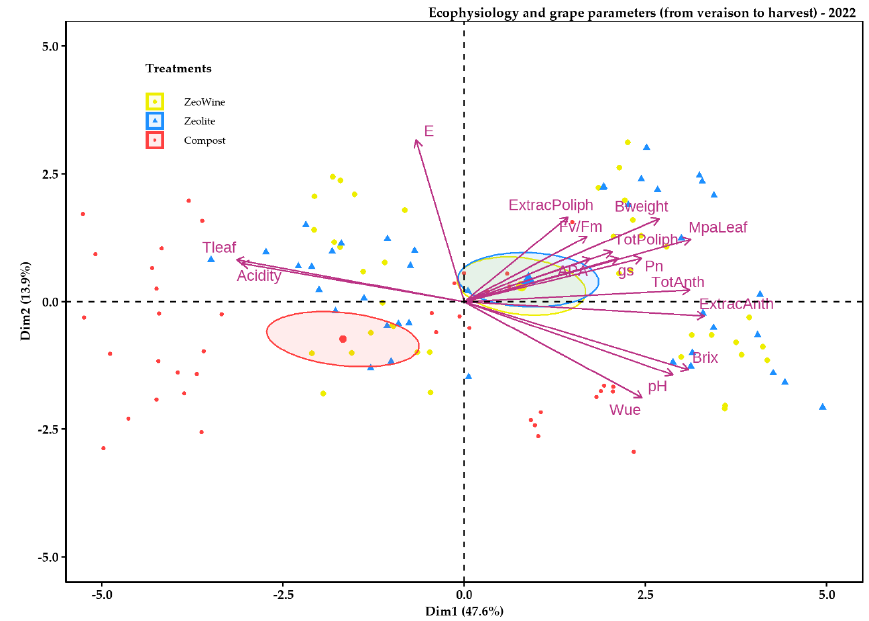
Figure 12. PCA ecophysiology and grape parameters 2022 season. PCA of the following variables (18 July, 4 August, 17 August, and 5 September): stem midday water potential, net photosynthesis, transpiration, leaf temperature, stomatal conductance, the fluorescence of chlorophyll, water use efficiency, sugar content, pH, acidity, total and extractable polyphenol, total and extractable anthocyanins, and YAN.